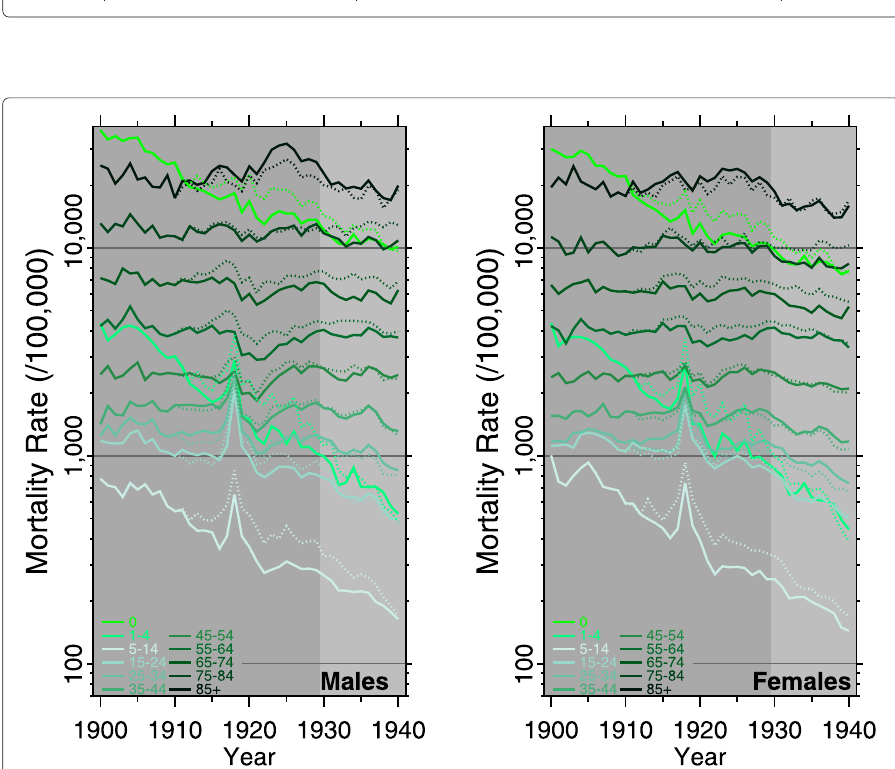
Fig.7 Mortality rates by age, 1900–1940, nonwhites. Solid lines are for the death registration area (1900–1932) and USA (1933–1940); dotted lines are for the death registration states of 1910 (1910–1940). Darker shading denotes input data to Lee-Carter model (up to 1929), but note that 1918 is excluded from the input